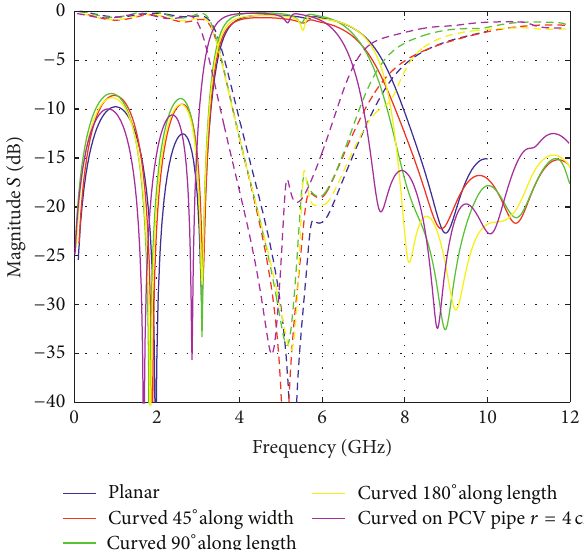
Figure 14: Simulated magnitude of the scattering parameters for the filter in its planar and curved version. 𝑆 11 : solid line. 𝑆 21 : dashed line.